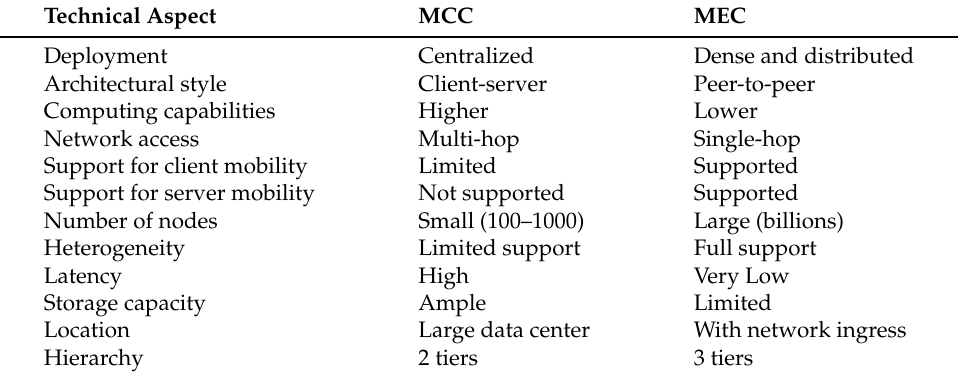
Table 1. Comparison between mobile cloud computing (MCC) and multi-access edge computing (MEC) computing